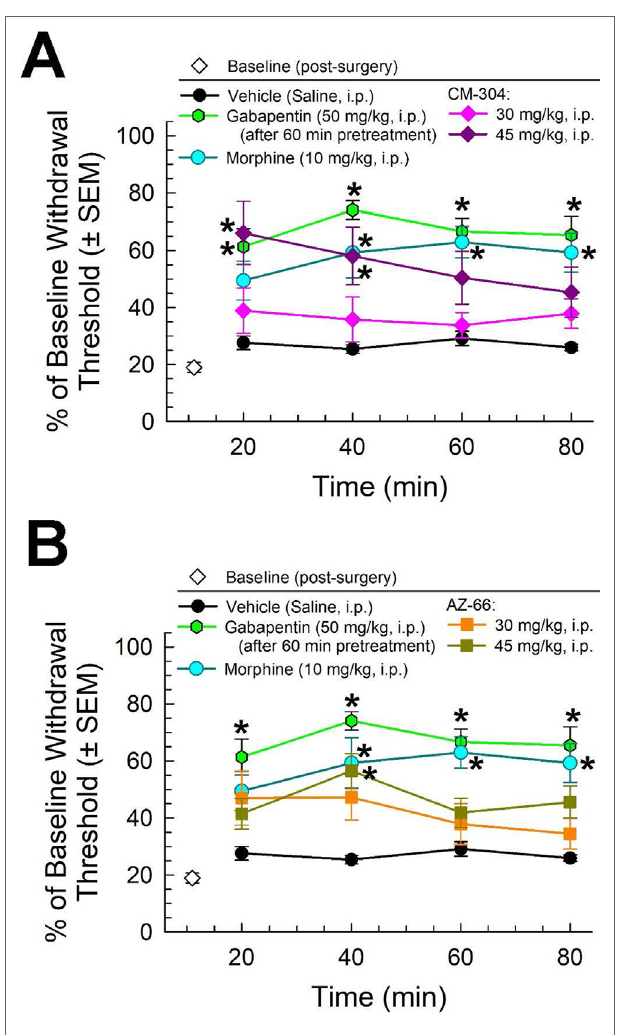
FIGURE 4 | Dose- and time-dependent antiallodynic activity of (A) CM-304 (diamonds) and (B) AZ-66 (squares) in the mouse chemotherapy-induced neuropathy (CISN) assay. Morphine (blue circles) and gabapentin (green hexagons, 60-min pretreatment) are included as positive controls; vehicle (saline; black circles) is included as a negative control. * = significantly greater than vehicle effect, p < 0.05; two-way ANOVA w/Tukey’s post hoc test. N = 9–10 mice treated with a single dose of sigma receptor antagonists, six mice treated with morphine, nine mice treated with gabapentin, and eight mice treated with saline alone.